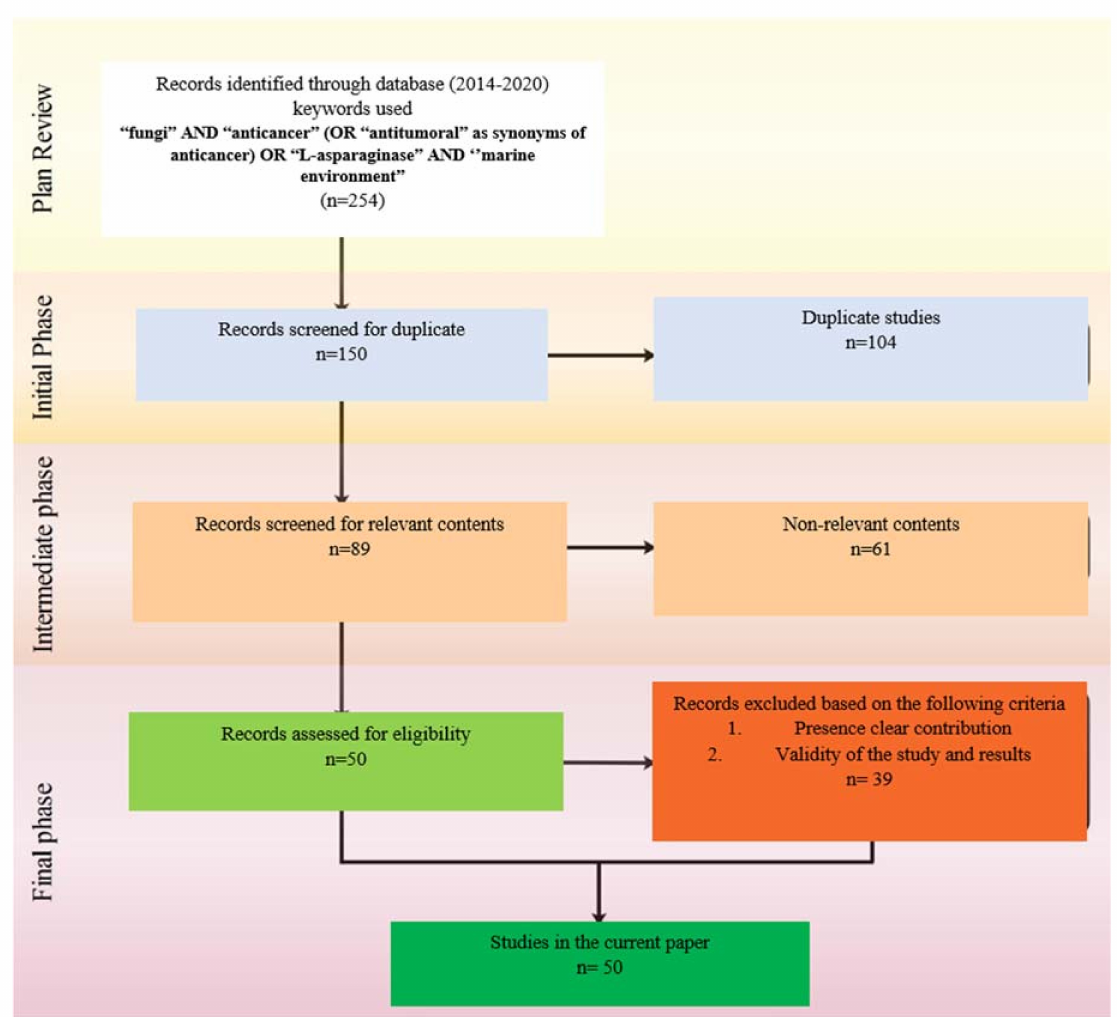
Figure 2. SLR Flowchart adopted with modification from the Preferred Reporting Items for Systematic Reviews and